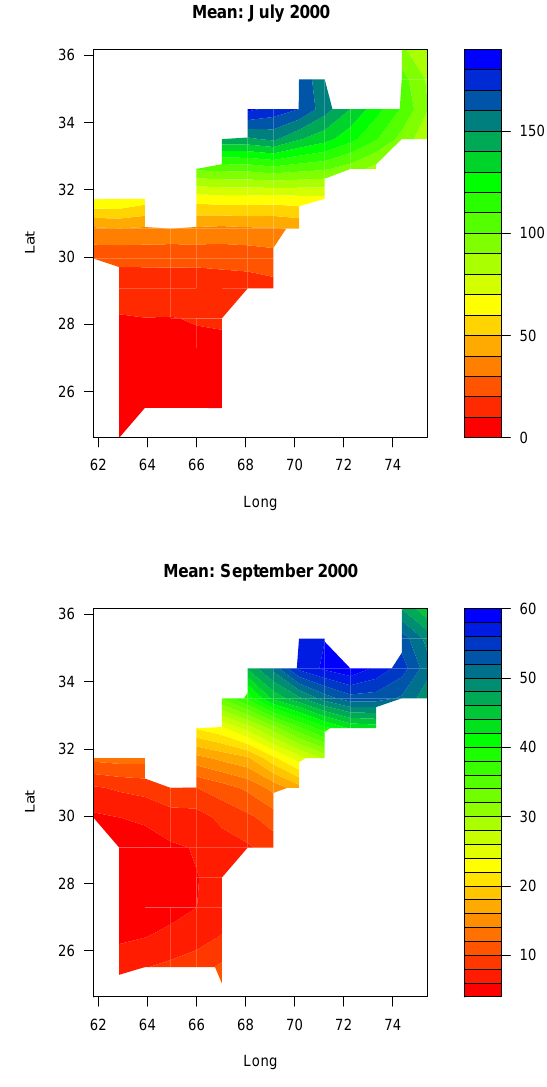
Fig. 8. The predicted maps for the months of July and September of year 2000 using the transformed hierarchical Bayesian model The BME and the Hierarchical Bayesian space-time model indicate heavy rain for the same regions, however, the Bayesian hierarchical model is also showing variations in the amount of rainfall for regions which received lower rainfall. The BME maps are showing spatial